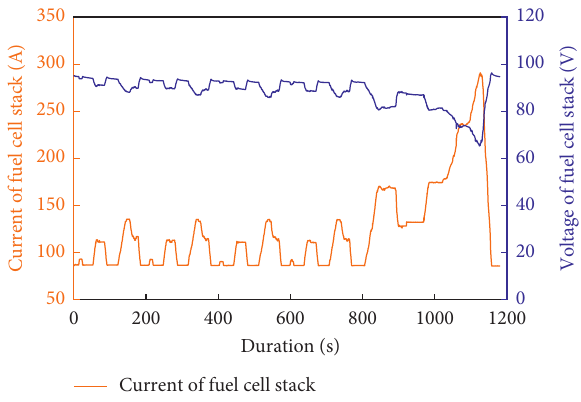
Figure 6: The voltage and current curve of fuel cell stack in 17th cycle of the test.